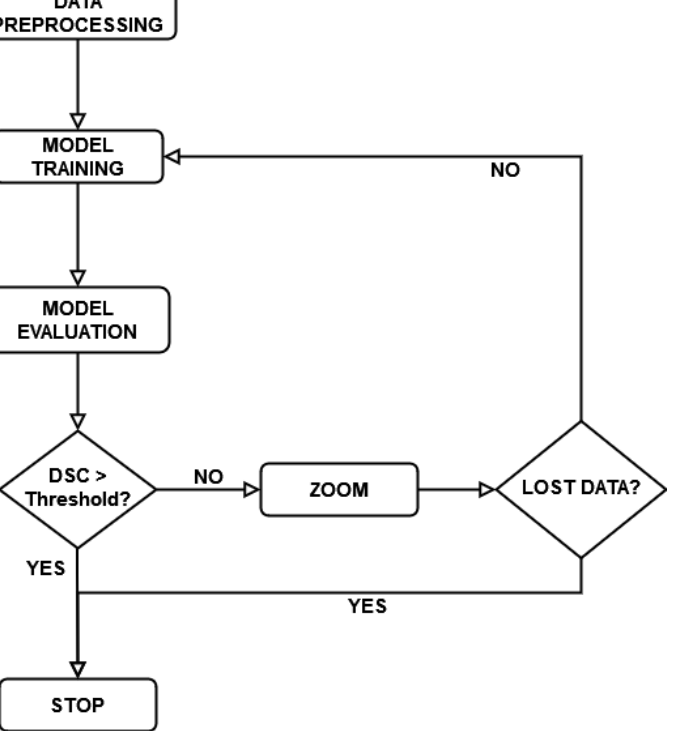
Figure 15. Flow diagram of the training of the mixed size medical segmentation procedure via